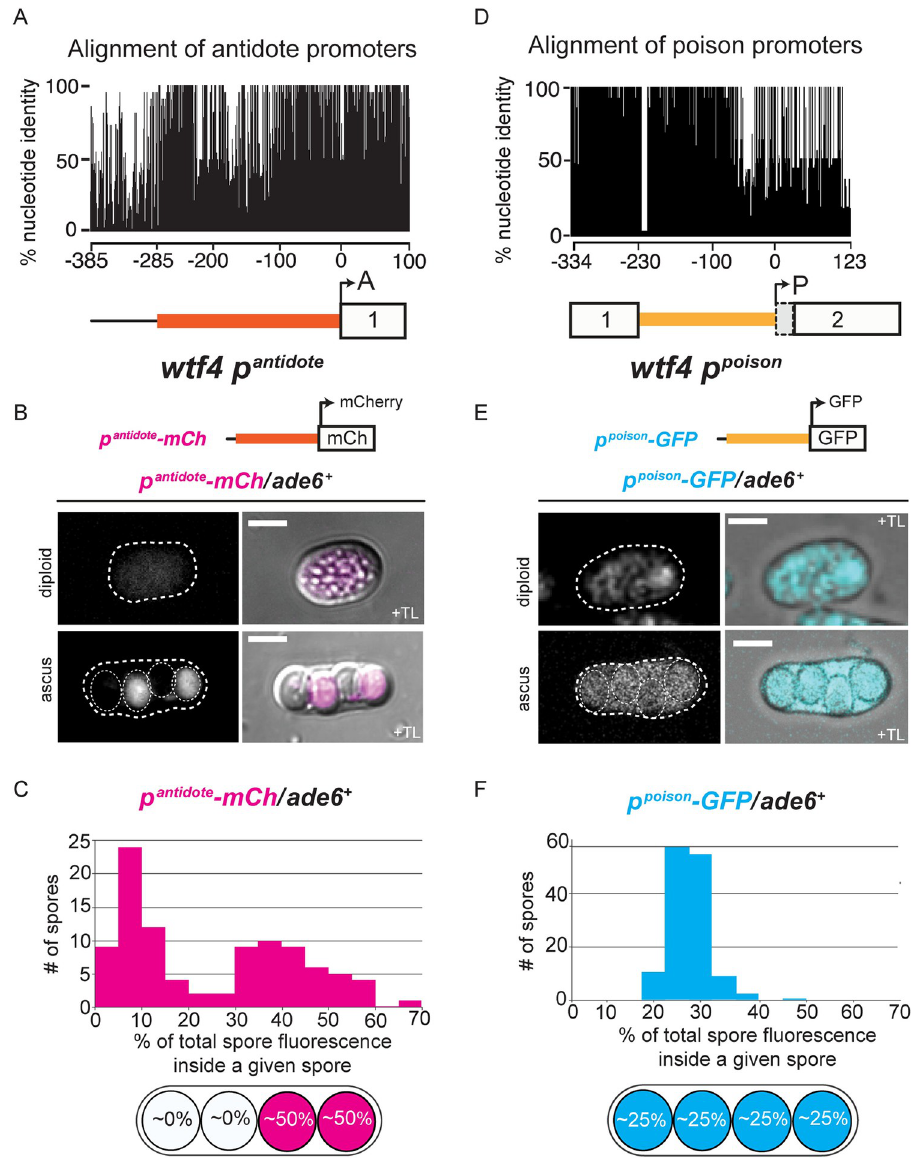
Fig 2. Distinct promoters largely explain differential localization of Wtf4 poison and Wtf4 antidote proteins. Depictions and alignments of ( A ) the wtf4 antidote promoter and ( D ) the wtf4 poison promoter are shown. For the alignment of antidote promoters, we aligned the 600 base-pairs upstream of 41 predicted antidote-only alleles [36] from three different strains of S . pombe (the reference genome, S . kambucha , and FY29033 , [85]). For the alignment of poison promoters, we aligned the intron 1 sequences (flanked by sequences 100 base-pairs upstream and downstream of intron 1) of 28 predicted poison-antidote wtf drivers [36] from three different strains of S . pombe (the reference genome, S . kambucha , and FY29033 ). The image shows the percent identity at each nucleotide position, excluding gaps. ( B ) Images of p antidote - mCherry/ade6+ diploid and ascus. ( C ) Quantification of mCherry fluorescence within p antidote - mCherry/ade6+ asci (n = 24). ( E ) Images of p poison - GFP/ade6+ diploid and ascus. ( F ) Quantification of GFP fluorescence within p poison - GFP/ade6+ asci (n = 34). All images were acquired after 3 days on sporulation media. For quantification, we assayed the fluorescence intensity within each spore and then divided that number by the total fluorescence intensity within all 4 spores. TL = transmitted light. All scale bars represent 2 μ m. Images of diploids are shown at the same brightness and contrast and were imaged at the same settings as the ascus generated from diploids of the same genotype.